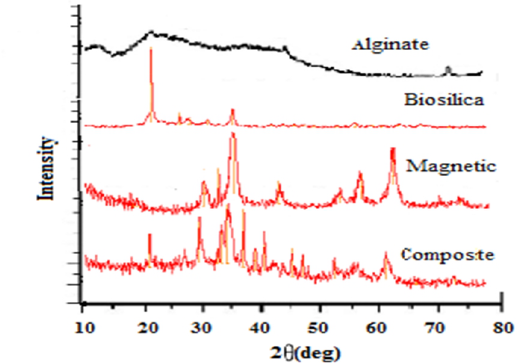
Fig. 3. XRD pattern of sodium alginate, biosilica, magnetic, and MBAS